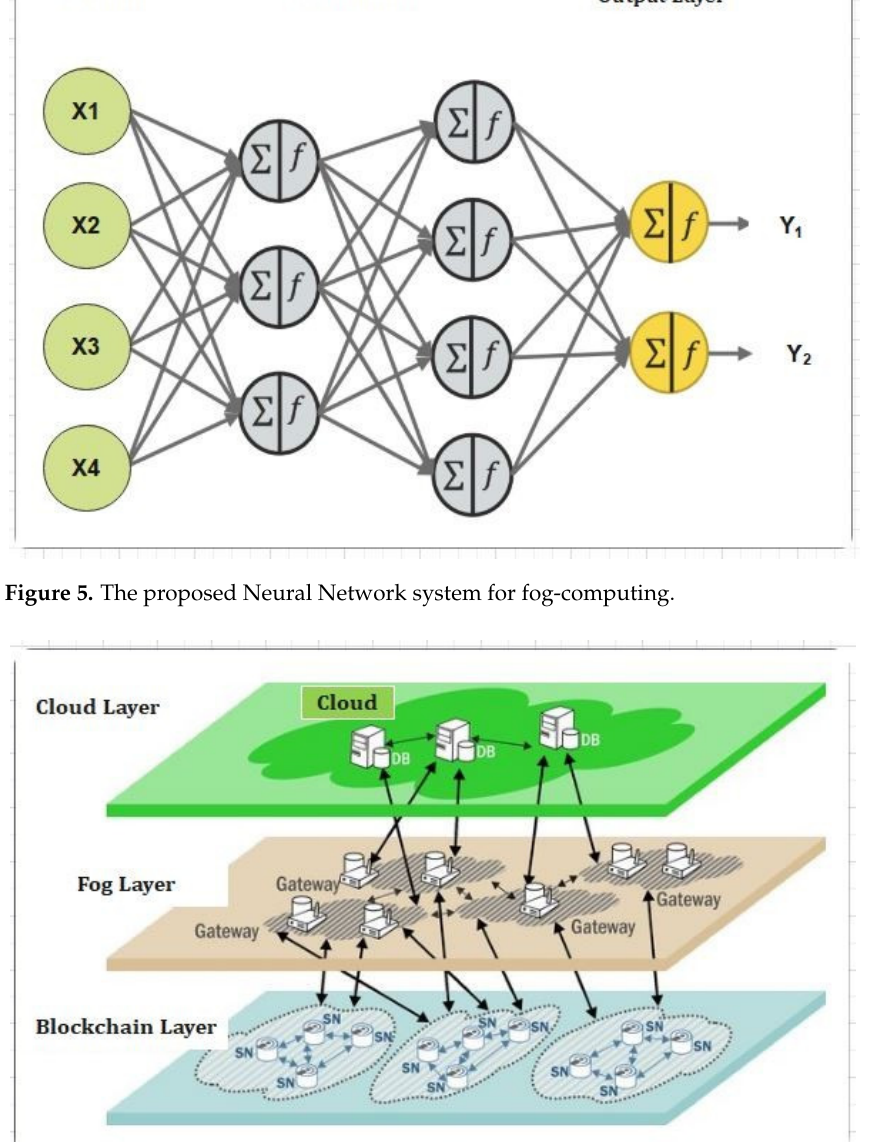
Figure 7. Proposed Neural Network system for fog-computing. 3.1.4. Proposed System Architecture Several physical servers combined in an FN configuration to cover a specific diameter region. The fog nodes (FN) can be wired or wirelessly connected [23–25]. The FN provides processors and sets up the equipment and network services as a small virtual data center. The processors, software, and network services made up the fog nodes (FN). Smart sensors (SS) collected data from the surrounding environment, which FN analyze and uses to understand decision-making better. The FN also provides a 5G network with a limited range of unicast wireless connections. Concurrent data transfer is enabled by the newly created 5G network protocols, which allow packets to be sent to all or a selected destination simultaneously [26]. The FN, a storage system for passive memory resident programs, can include the local database. For heavy